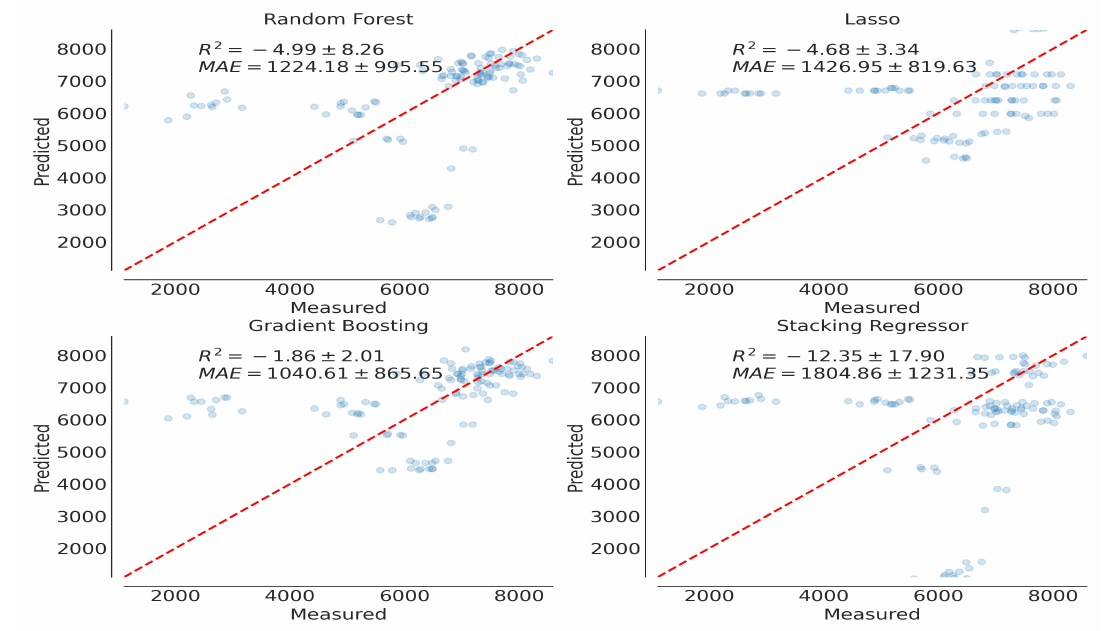
Figure 7. The plot of the predicted vs. true targets for crime values by stacked model.